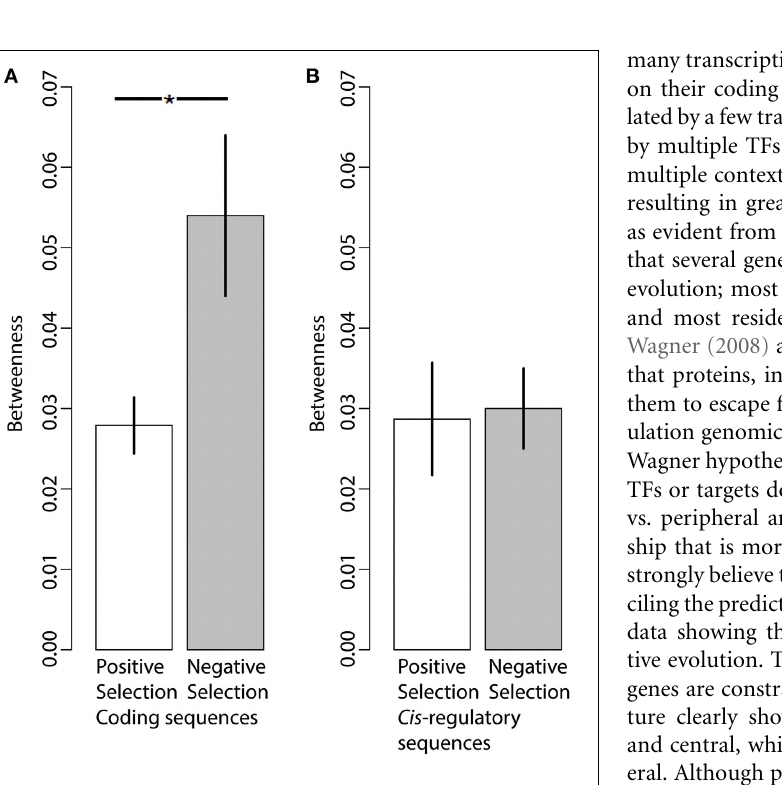
FIGURE 4 | Network position is associated with differences in coding sequence evolution but not regulatory sequence evolution. (A) Genes experiencing positive selection ( γ > 1)on their coding sequences ( N = 105) have significantly lower Betweenness centrality estimates (i.e., are further away from the network core) relative to genes experiencing negative selection ( γ < − 1) on their coding sequences ( N = 7). (B) The average Betweenness centrality of genes experiencing positive selection ( γ > 1) on their regulatory sequences ( N = 16) does not significantly differ relative to that of genes experiencing negative selection ( γ < − 1) on their regulatory sequences ( N = 92). Bars indicate Mean ± SEM. ∗ p < 0 .